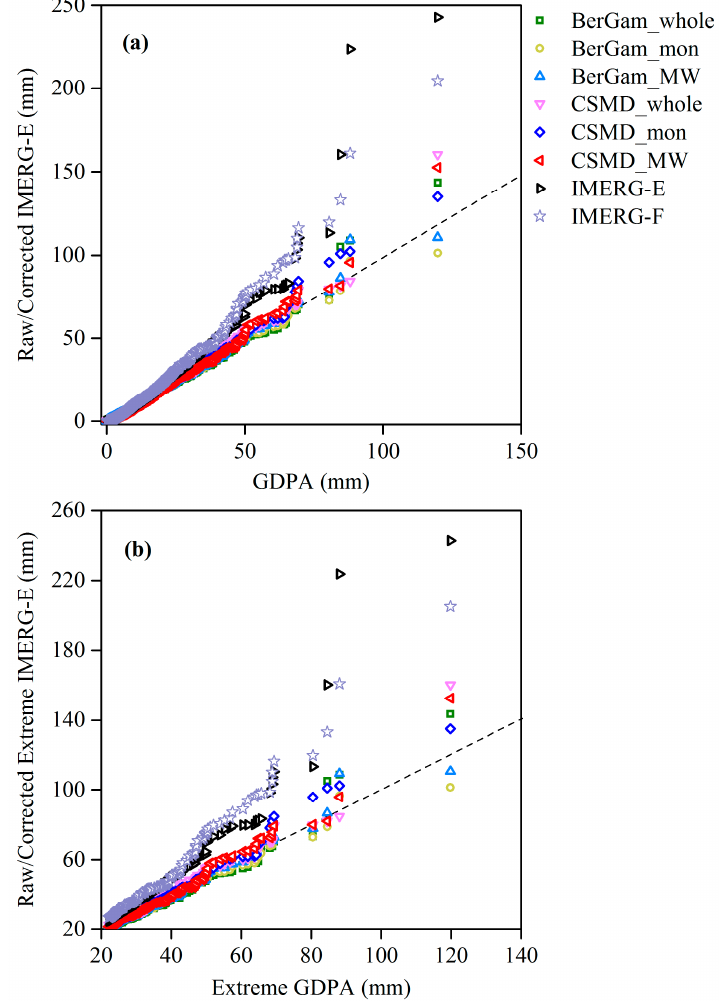
Figure 9. Quantile-Quantile plot (Q-Q plot) of the raw or corrected IMERG-E satellite precipitation and post-processed IMERG-F against ground reference GDPA precipitation over ( a ) the whole intensity range and ( b ) the extreme range. The threshold of extreme precipitation is set to the 97.5 percentile, than which precipitation is greater was selected as extreme values.